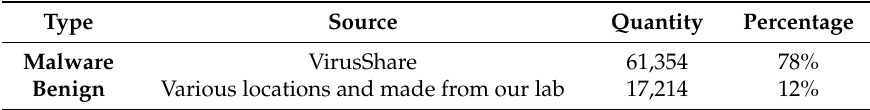
Table 1. Summary of dataset created as per